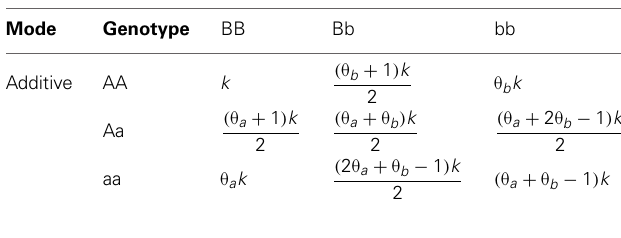
Table 1 | Penetrance pattern under additive genetic mode for two-locus main effect